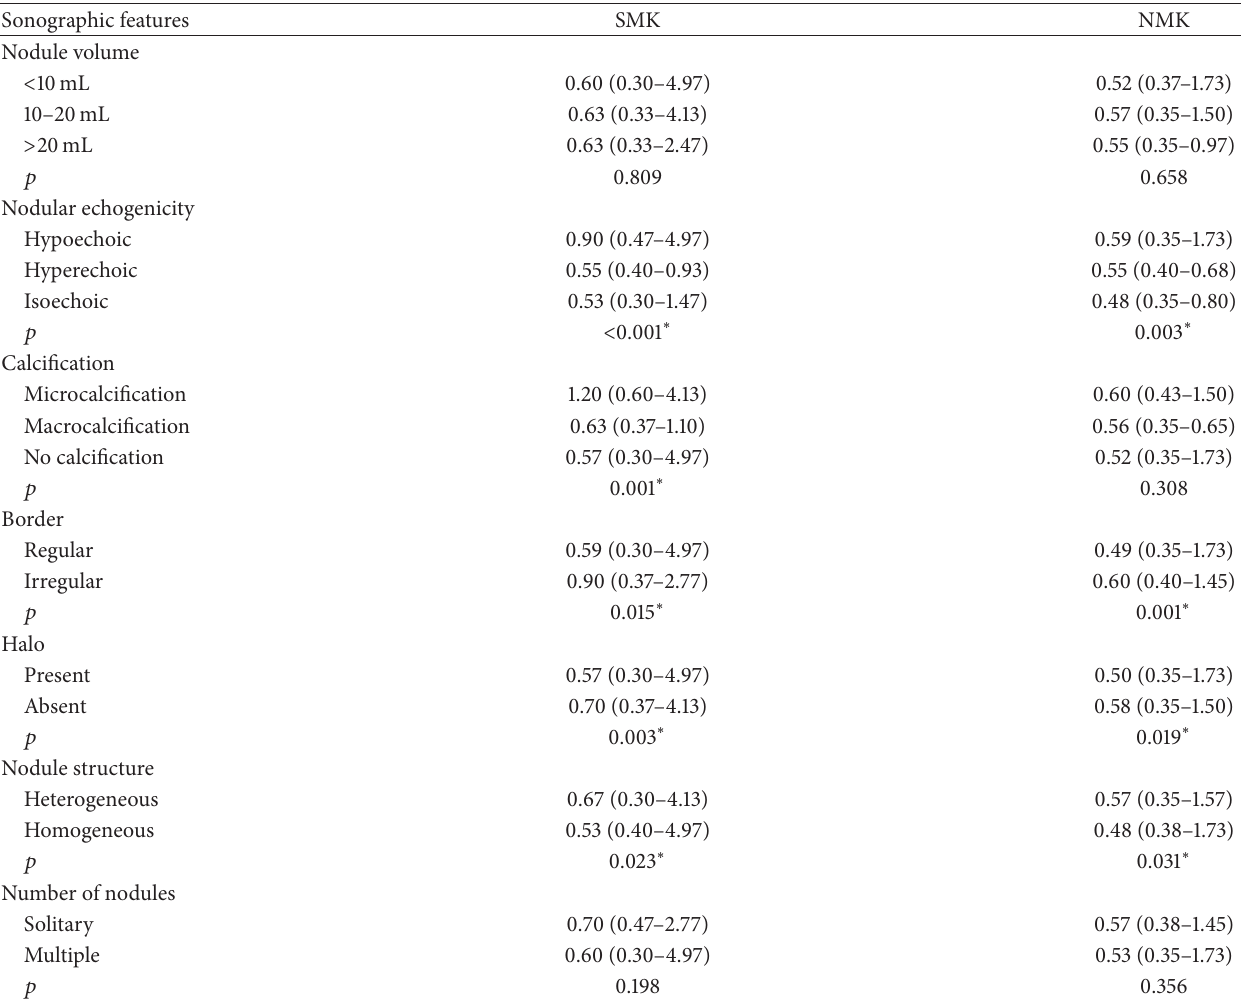
Table 2: Sonographic correlations of SMK/NMK